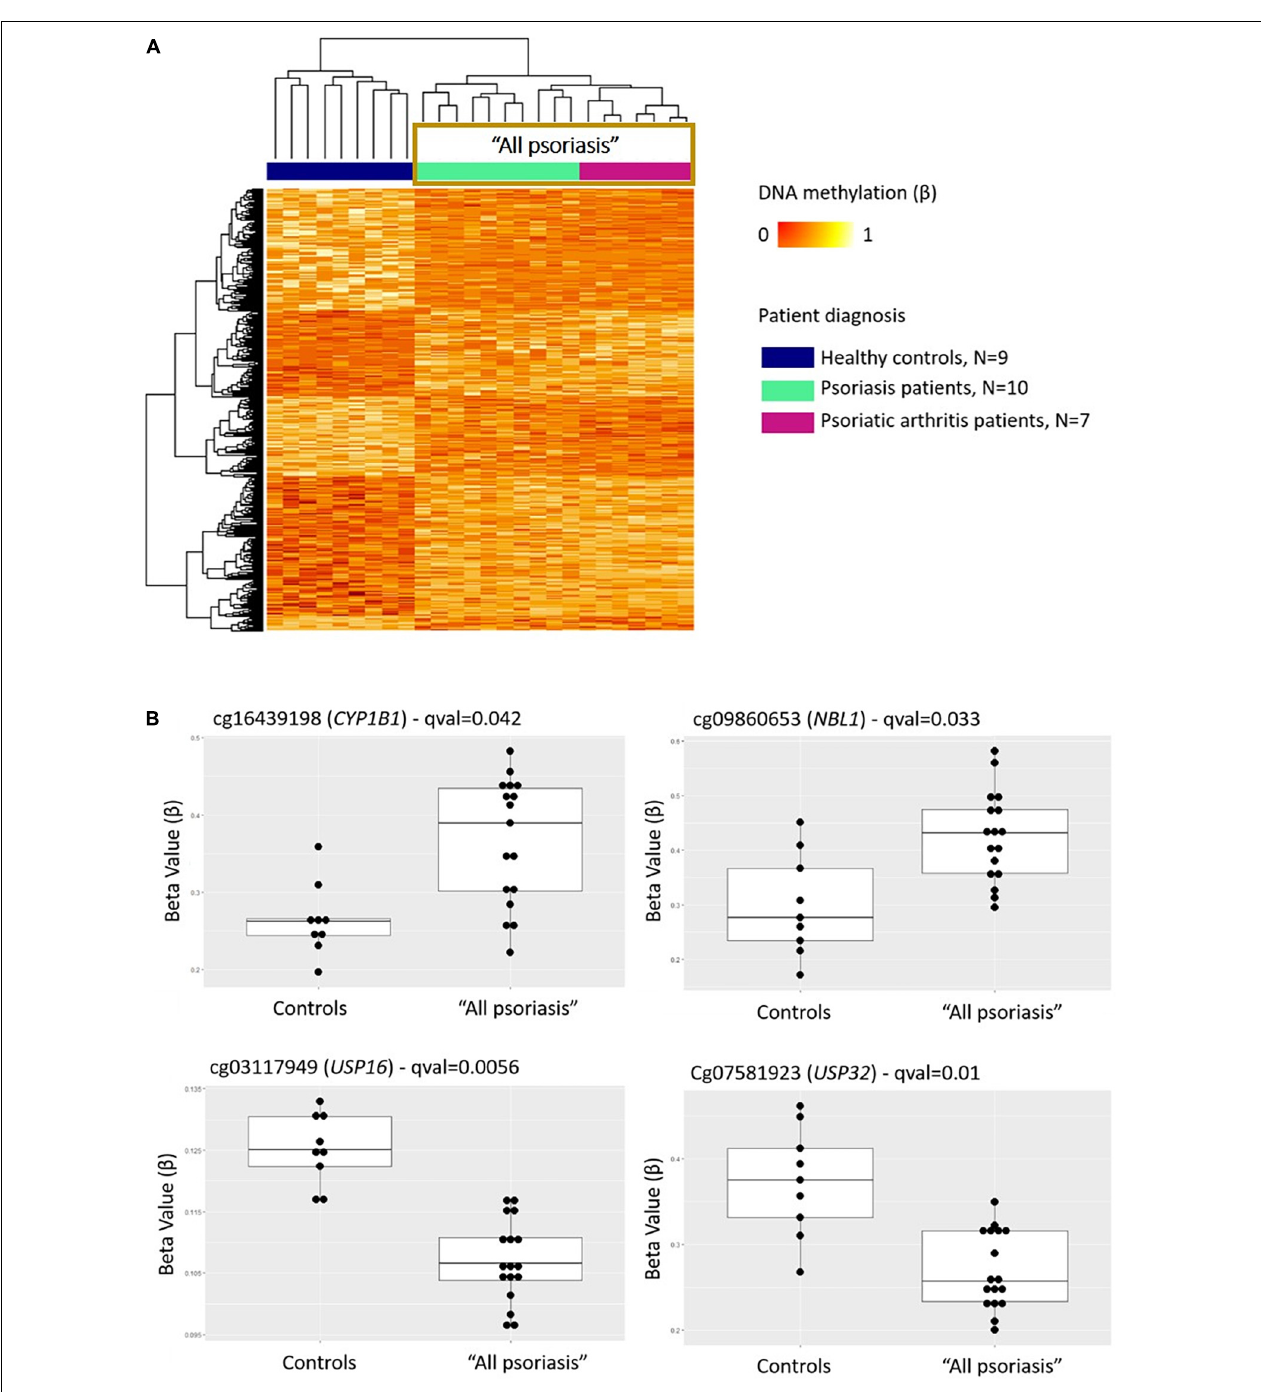
FIGURE 1 | DNA methylation profiles differentiate CD8 + T cells from psoriasis patients and healthy individuals. (A) Heat map showing differentially methylated positions (DMP) between “all psoriasis” (combined psoriatic arthritis and psoriasis patients) patients and healthy controls (FDR < 0.05, | (cid:49) β | > 0.1). Normalized DNA methylation levels are displayed on the right with red indicating reduced methylation and yellow indicating increased methylation levels. (B) Differences in beta values of selected CpG sites identified as DMPs across “all psoriasis” patients versus healthy controls. “All psoriasis,” Psoriasis and PsA patients combined.